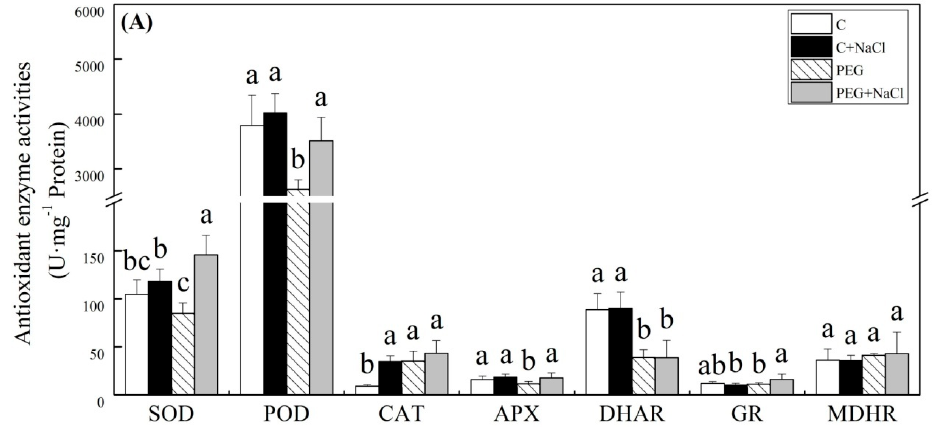
Figure 6. Effects of seeds soaking with water or NaCl (1 mM) on ( A ) ascorbic acid (ASA), ( B ) dehydroascorbic acid (DHA), ( C ) reduced glutathione (GSH), and ( D ) oxidized glutathione (GSSG) content after seven days of germination under normal conditions and water stress induced by 19% polyethylene glycol (PEG) 6000. Vertical bars indicate ±SE of mean ( n = 6). Different letters above columns indicate significant differences ( p ≤ 0.05).